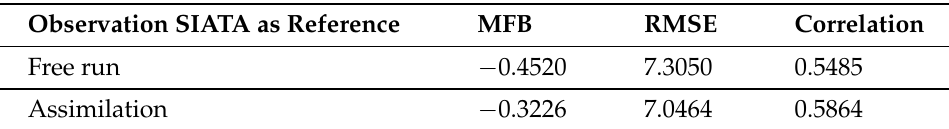
Table 2. Different statistics to quantify the change between the assimilated and non assimilated output respect the surface observation in the Aburrá Valley.